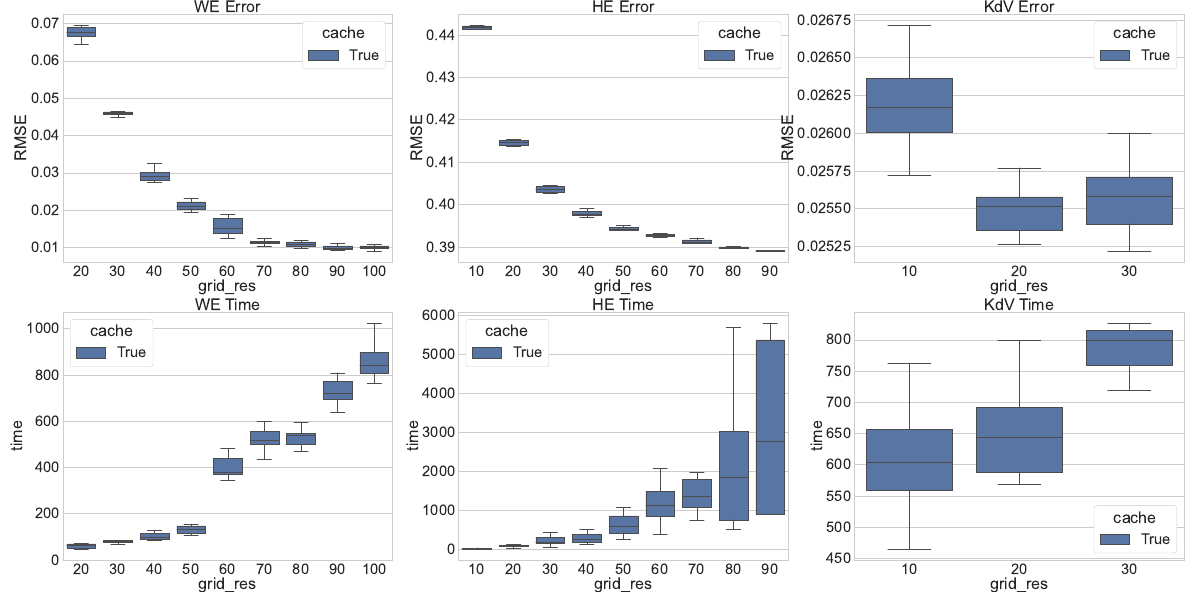
Figure 9. Summary of all PDE experiments: upper row errors and lower time. From ( left ) to ( right )—wave equation, heat equation, and Korteweg–de Vries equation.